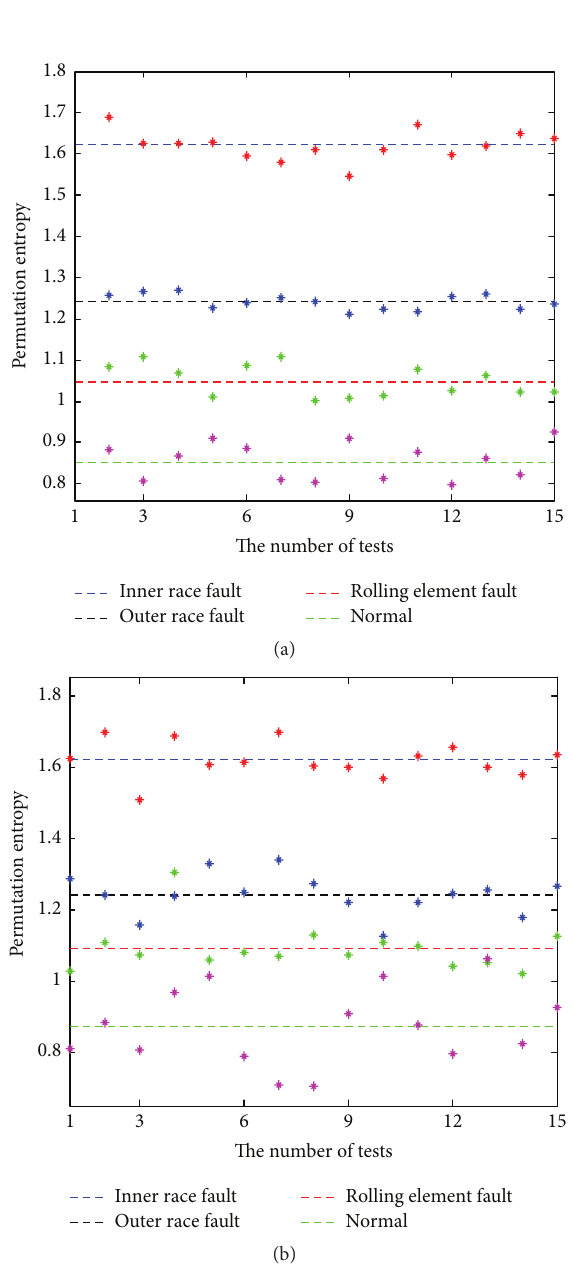
Figure 9: (a) Permutation entropy of LCD. (b) Permutation entropy of